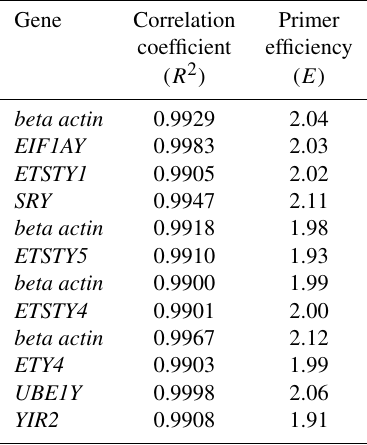
Table 2. Correlation coefficient of the standard curve and the primer efficiency for eight horse Y chromosome